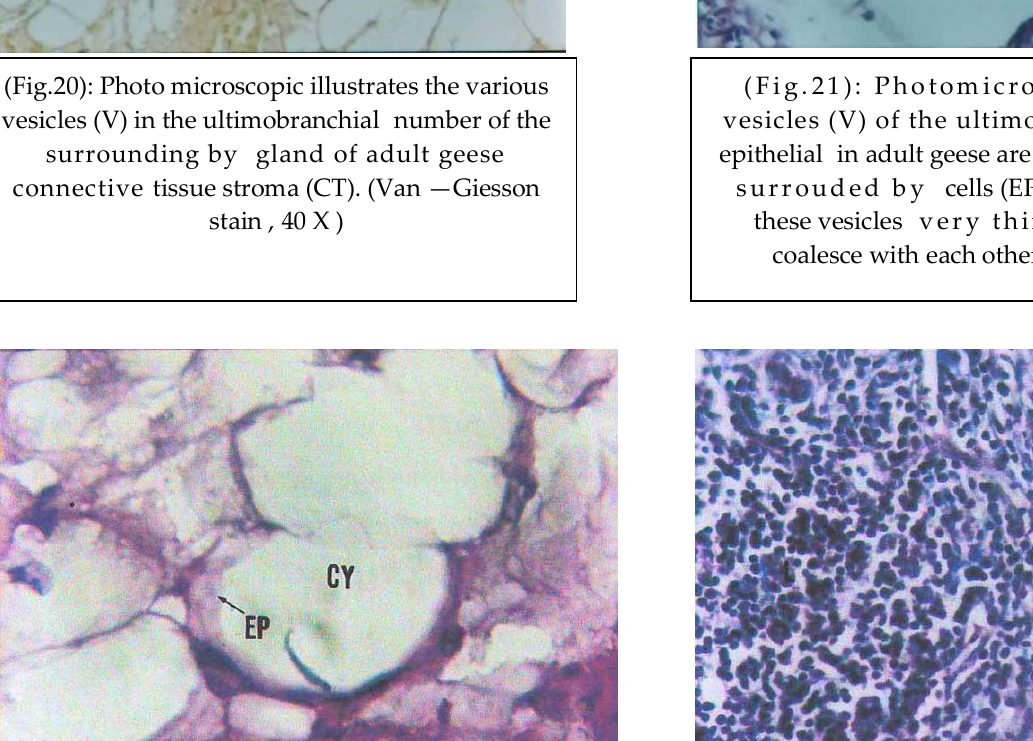
(Fig.23): Photomicroscopic illustrates a single lymphoid foci (L) in ultimobranchial gland of young geese situated peripherally, also it illustrates the small lymphocytes (1y) scatter in the stroma of the gland.( Masson trichrome stain, 40